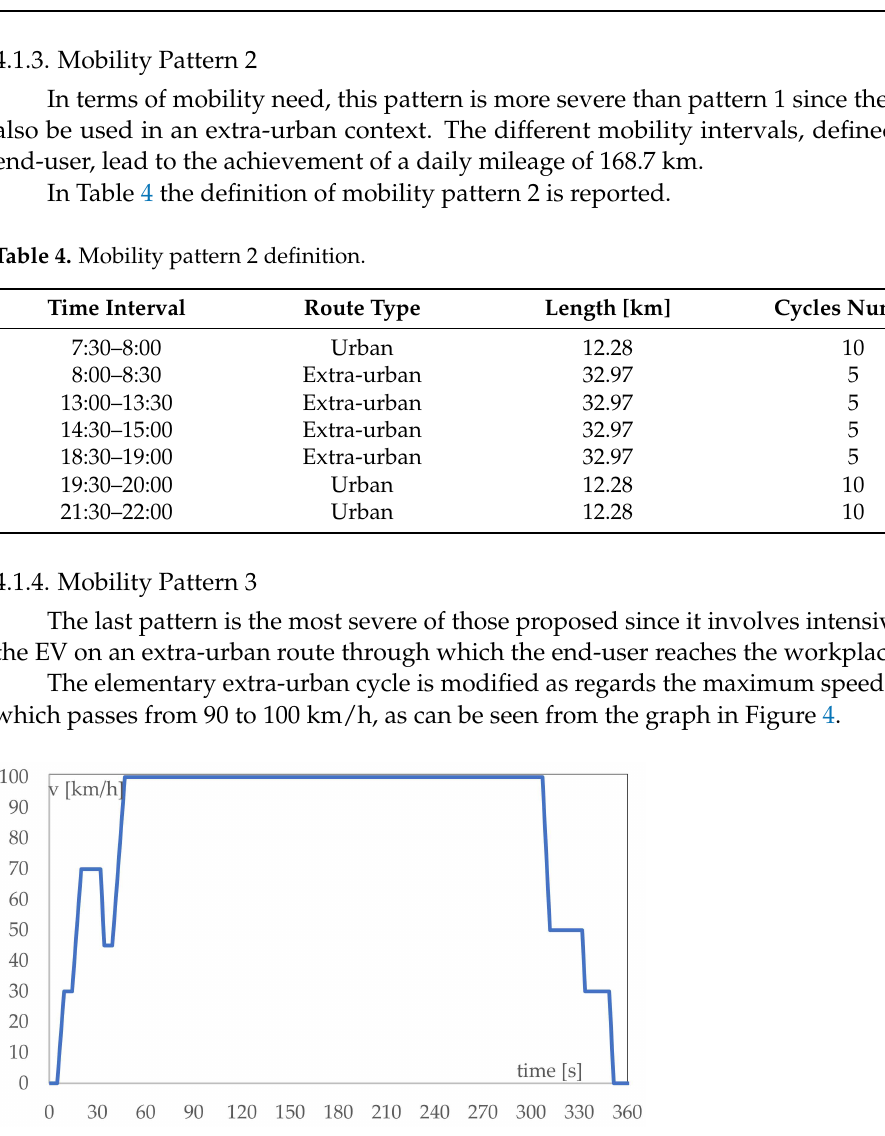
Figure 4. Speed profile in the modified elementary extra-urban